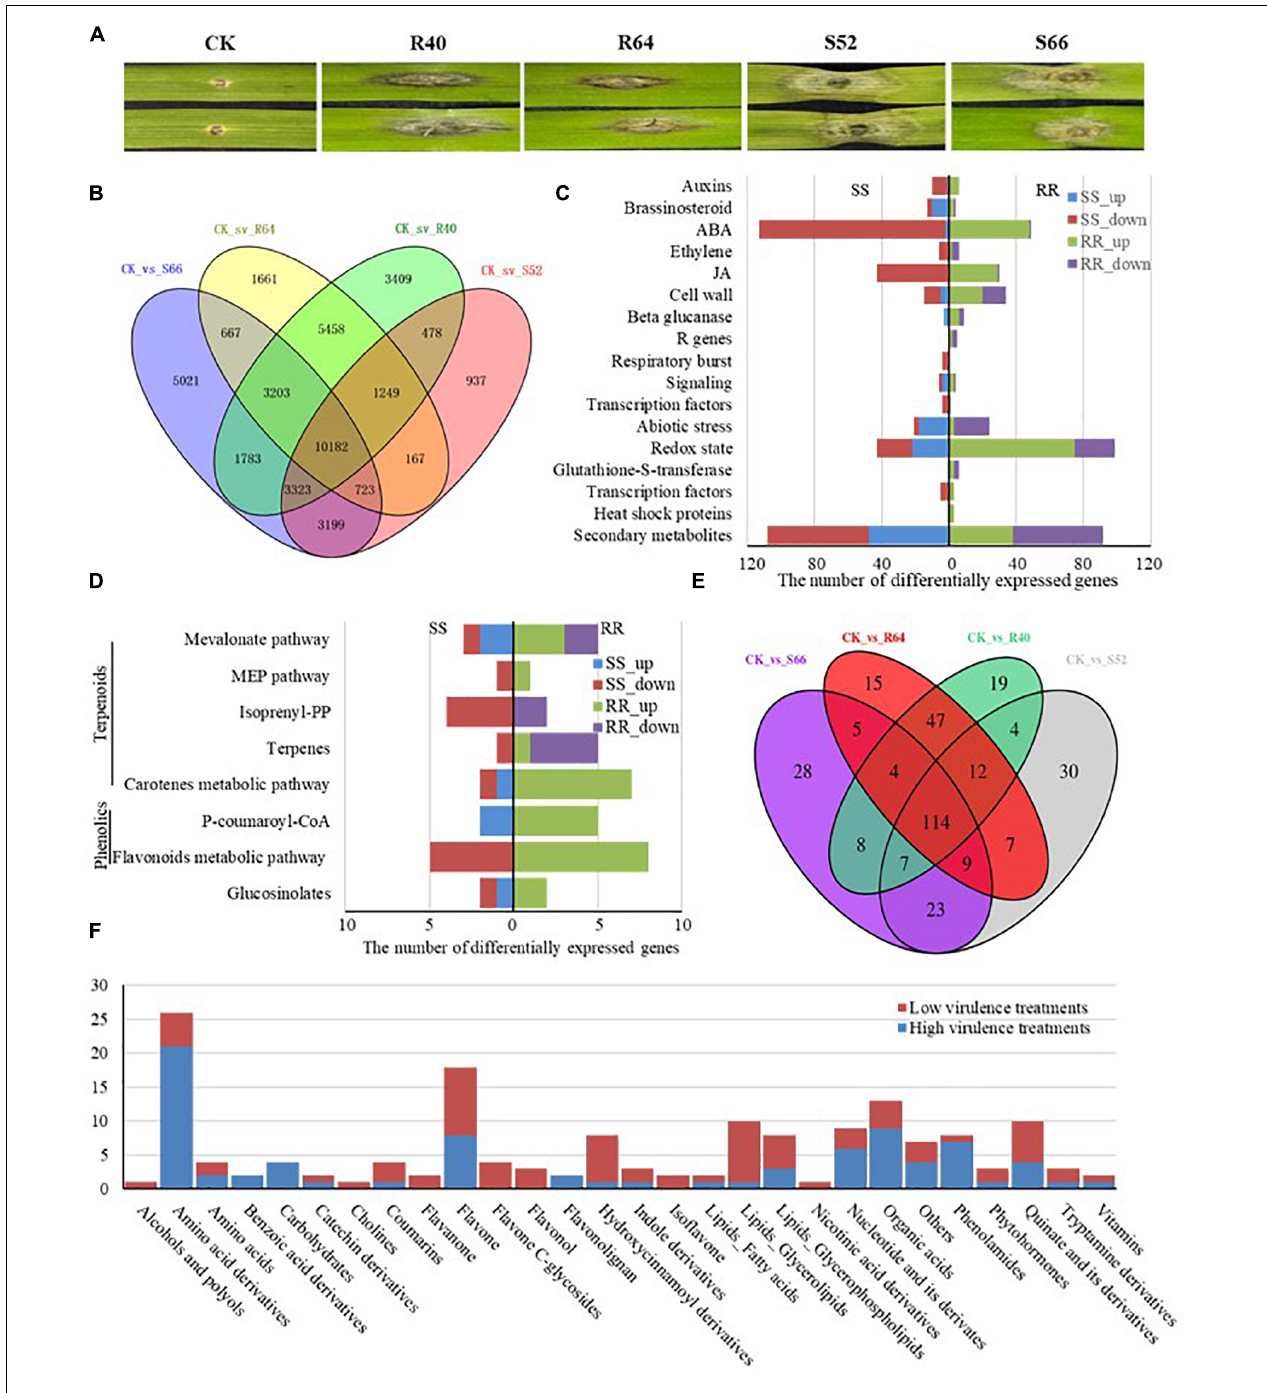
FIGURE 2 | Overview of significantly differentially expressed genes (DEGs) and the accumulated metabolites in detached leaves of Sumai 3 treated with the F . graminearum isolates R40, R64, S52, and S66. (A) The symptoms on the detached leaves inoculated with H 2 O, low virulent isolates (R40 and R64), and high virulent isolates (S52 and S66). (B) Venn diagram of significantly DEGs induced by R40, R64, S52, and S66 compared with CK. (C) A number of significant DEGs were mapped to the corresponding pathways in biotic stress pathways. (D) A number of significant DEGs were mapped to the secondary metabolism pathway. (E) A Venn diagram of the different metabolites induced by R40, R64, S52, and S66 compared with CK. (F) Number of specific metabolites in different categories after inoculating with high- and low-virulence F . graminearum .